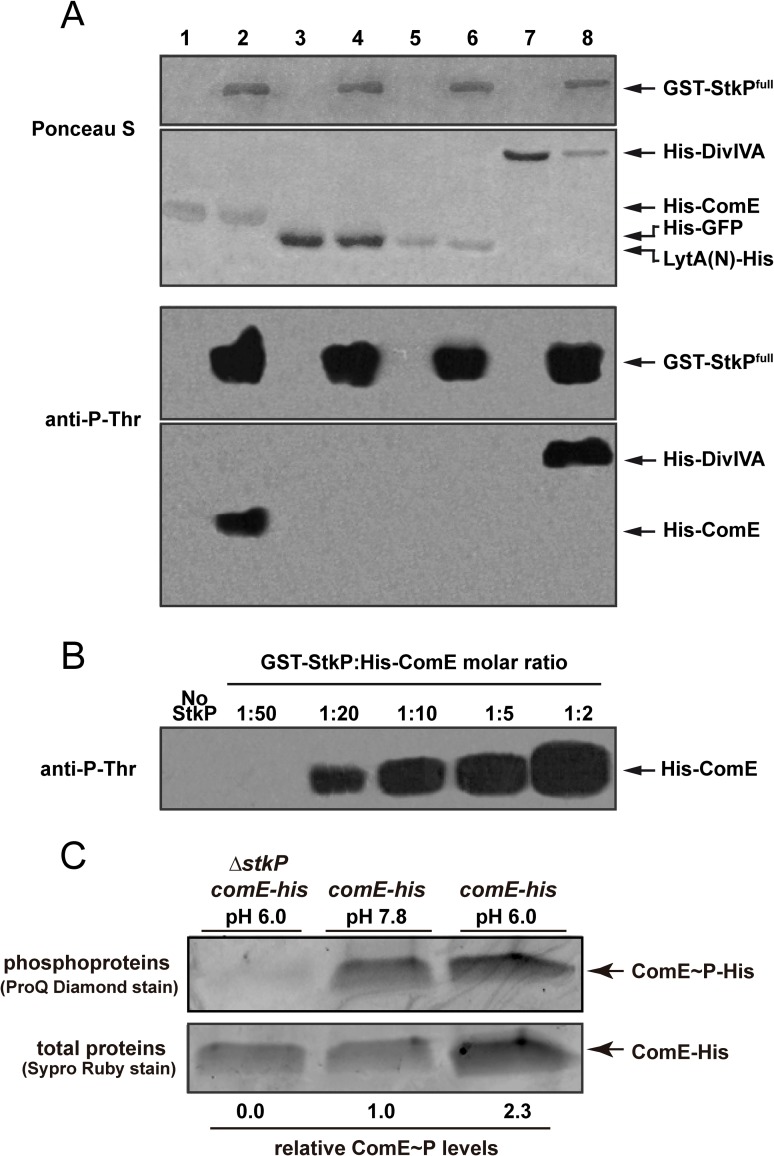
ComE is phosphorylated by StkP.(A) ComE is phosphorylated at a threonine residue by StkP. Top: nitrocellulose membrane stained with Ponceau S as a loading control. Bottom: Immunodetection of phosphorylated proteins. Phosphorylation reactions were carried out with purified GST-StkP and substrate proteins (0.5 μg each) mixed in kinase buffer and incubated at 37°C for 1 hour. Phosphorylated proteins were detected with an anti-phosphothreonine polyclonal antibody. Lane 1: Hisx6-ComE. Lane 2: Hisx6-ComE + GST-StkP. Lane 3: Hisx6-GFP. Lane 4: Hisx6-GFP + GST-StkP. Lane 5: LytA(N)-Hisx6. Lane 6: LytA(N)-Hisx6 + GST-StkP. Lane 7: Hisx6-DivIVA. Lane 8: Hisx6-DivIVA + GST-StkP. (B) ComE phosphorylation assays with different StkP:ComE molar ratios. GST-StkP and Hisx6-ComE were mixed at different molar ratios in kinase buffer and incubated at 37°C for 1 hour. Detection of phosphorylated proteins was performed as described above. (C) In vivo StkP-dependent and acid-induced ComE phosphorylation. C-terminal His-tagged ComE was purified from wt and ΔstkP strains grown in ABM (pH 7.8), and exposed to acidic stress in medium MD5, pH 6.0. Protein samples were separated by SDS-PAGE and phosphorylated or total ComE-His was detected with Pro-Q Diamond and SYPRO Ruby staining, respectively.